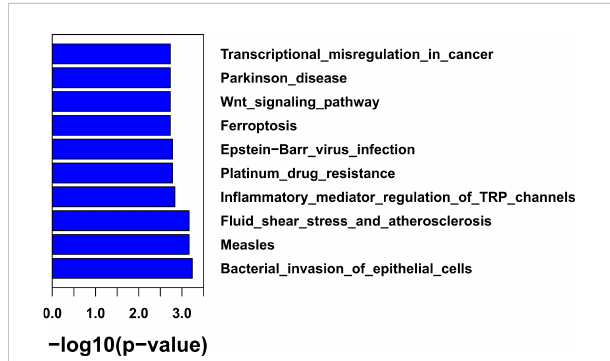
FIGURE 3 The functional enrichment of genes with mutations in high-grade